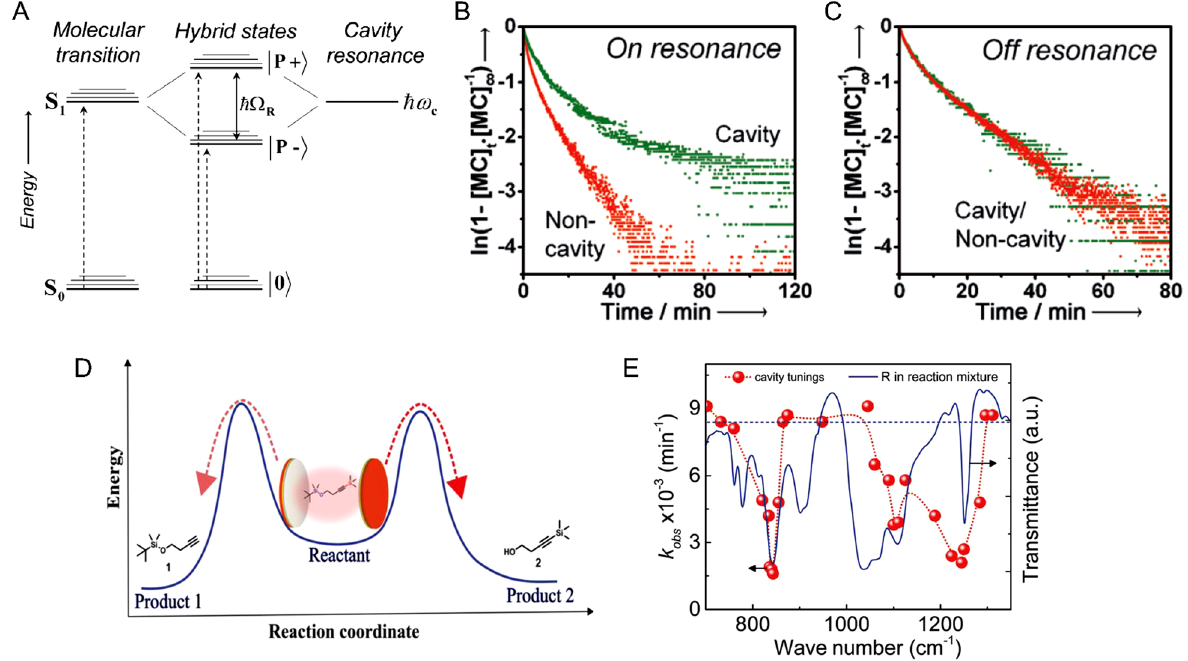
Figure5: Vacuumfluctuationsaffectingchemistry.(A)Schematicofthehybridizationofenergystateswhenthemolecularelectrontransitions arestronglycoupledwithvacuumfluctuationsinacavity.Thekineticsofthephotoisomericconversionfromspiropyran(SPI)intomerocyanine (MC)measuredforbaremolecules(red)andmoleculescoupledwithcavityvacuumfluctuation(green)inboth(B)on-resonance(whencavityis tuned on resonance with the MC absorption wavelength at 560 nm) and (C) off-resonance cases. (D) Schematicof two silyl cleavage pathways for a silane derivative with tetrabutylammonium fl uoride in a 1:1 mixture of methanol and tetrahydrofuran. (E) The total reaction rate as a functionof cavity tuning(red dots)is modi fi ed fromthe rate outsideof the cavity(blue dashedline)whenthe cavityis tunedinresonancewith the transmission dips (solid blue line) that correspond to the vibrational modes from the infrared absorption spectrum. (A, B, and C) Reproduced with permission from the study by Hutchison et al. [136]. Copyright 2012, Wiley-VCH. (D and E) Reproduced with permission